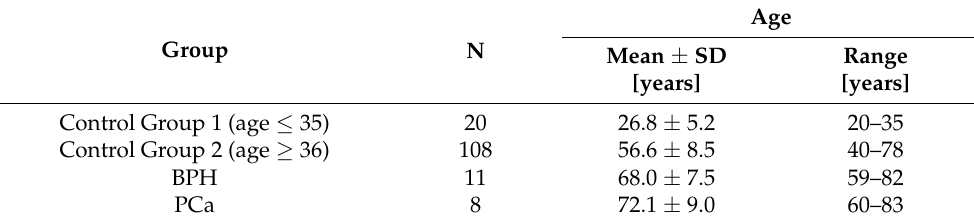
Table 1. Characteristics of the investigated